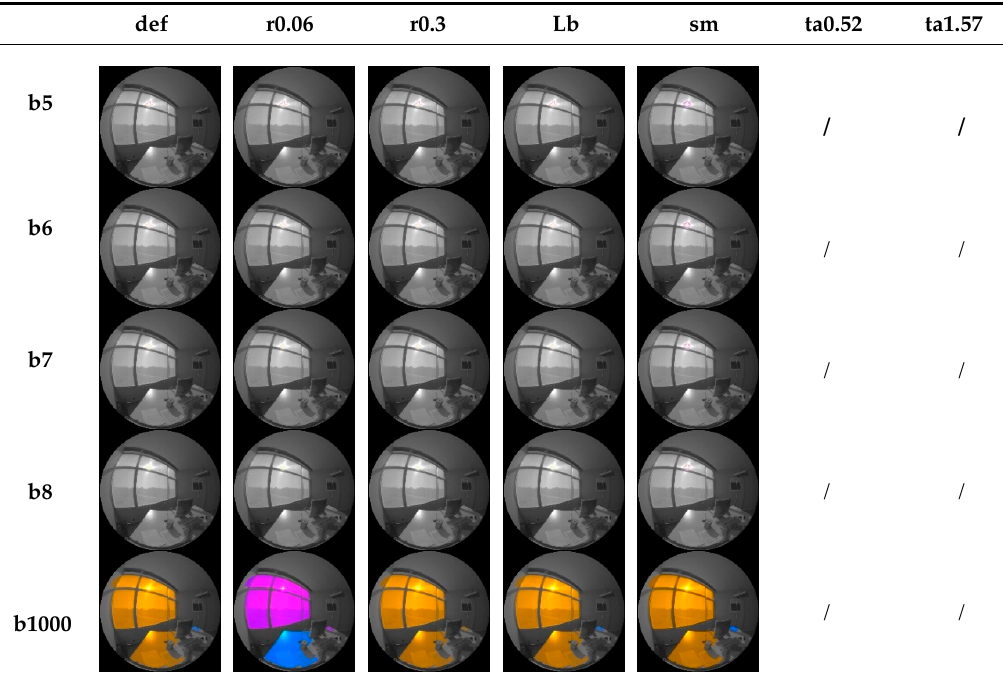
Table 2. Example of a visual scene from the lab study of differences in glare source detection for all of the evalglare options tested.